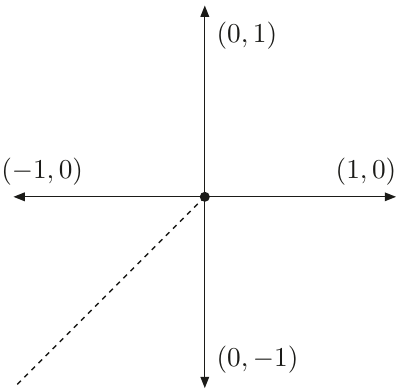
Figure 3 . A toric fan for P 1 × P 1 can be obtained by removing the edge ( − 1 , − 1) from the toric fan for dP 2